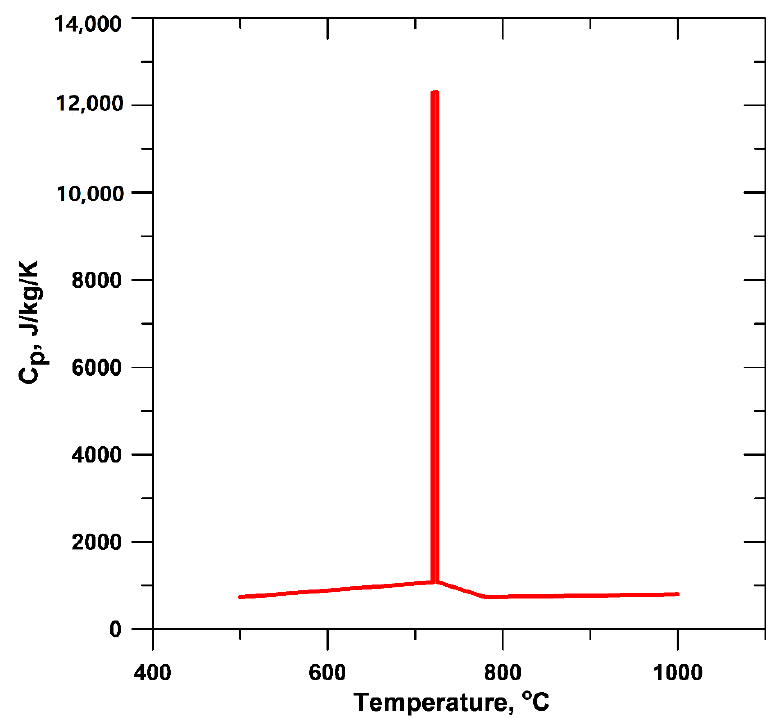
Figure 5. Specific heat as function of temperature.